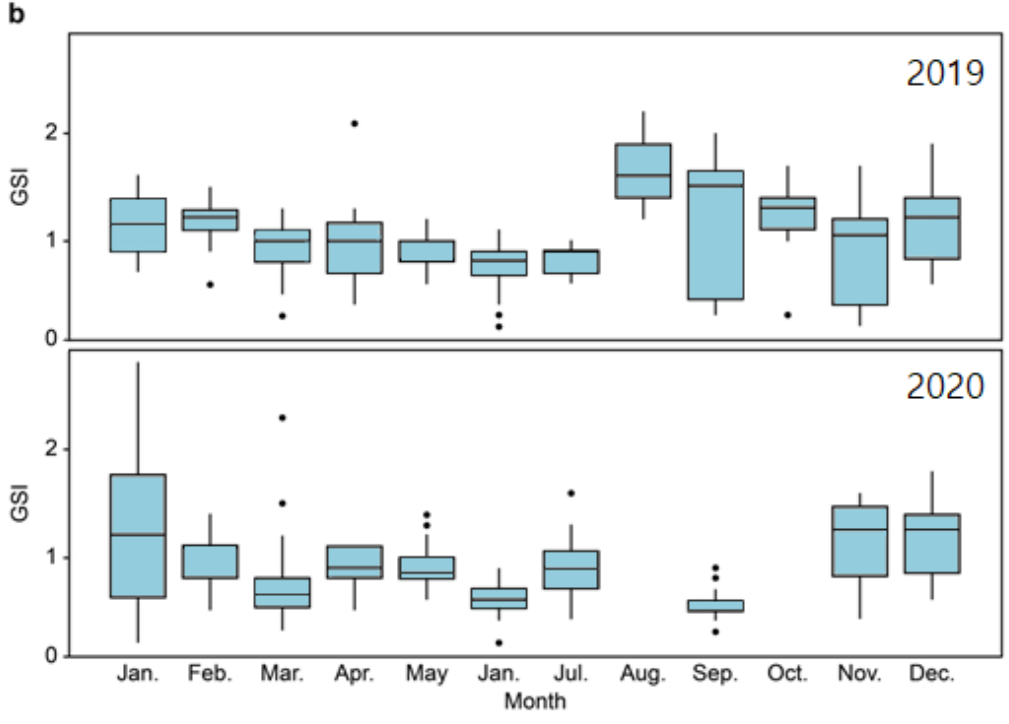
Figure 7. Temporal variation in the gonadosomatic index (GSI) of female ( a ) and male ( b ) ocellate spot skate Okamejei kenojei specimens collected from the West Sea of Korea in 2019 and 2020.